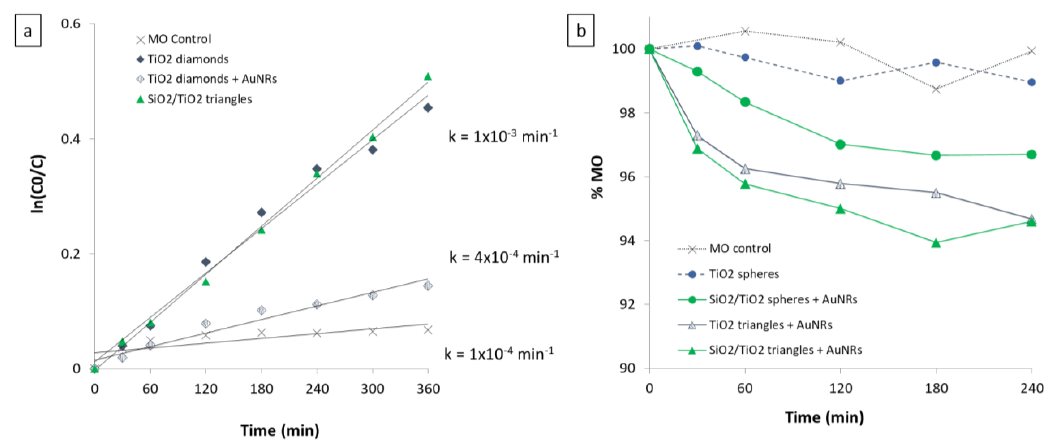
Figure 11. ( a ) Photodegradation rate of MO upon exposure to UV light and ( b ) percentage of methyl orange degradation over time upon Vis light.